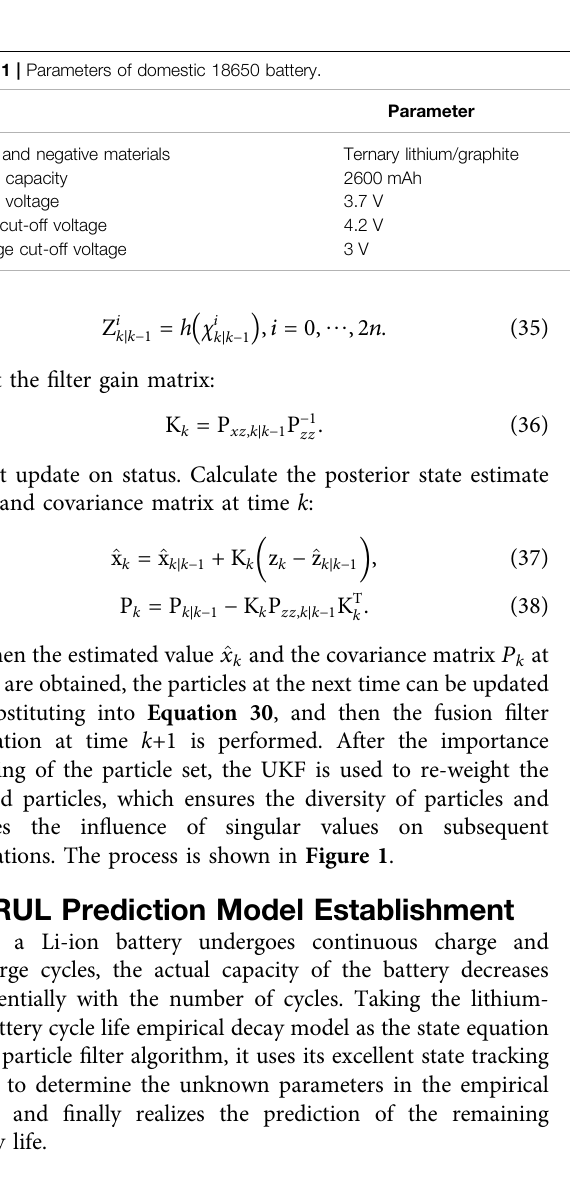
FIGURE 1 | Flowchart of the fusion particle fi lter algorithm.